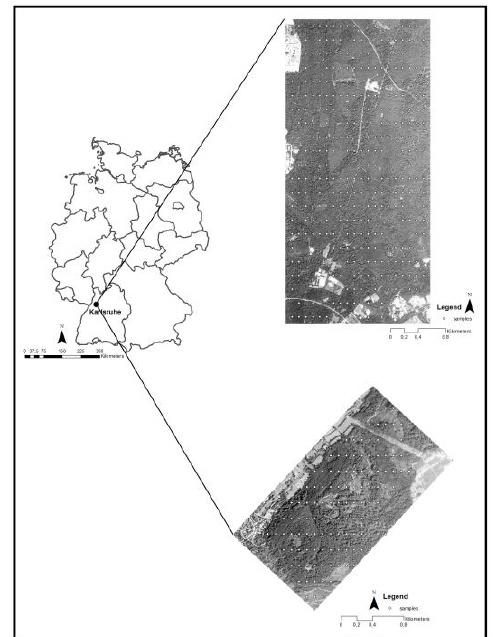
Fig.1. Geographical location of the study area in Germany, overlaid by the ground